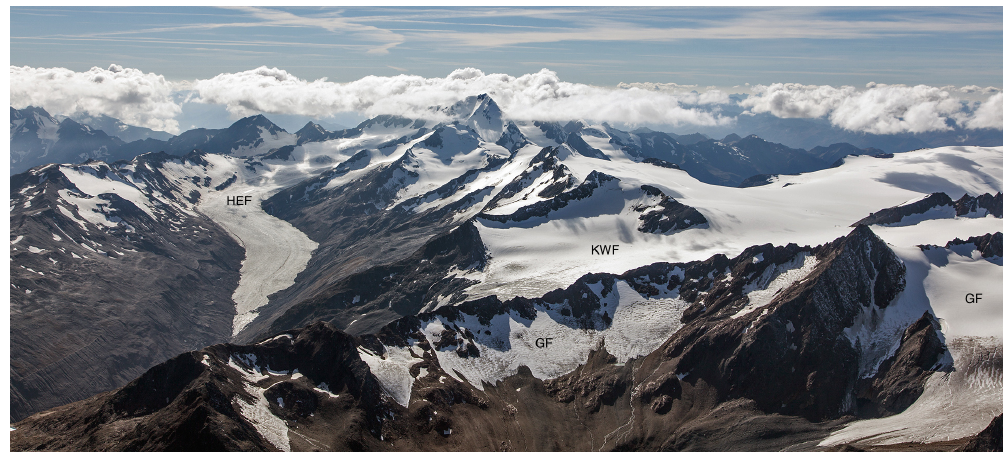
Figure 3. State of Hintereisferner (HEF), Kesselwandferner (KWF) and Guslarferner (GF) on 28 September 2014. Aerial photo by Christoph Mayer, view to the